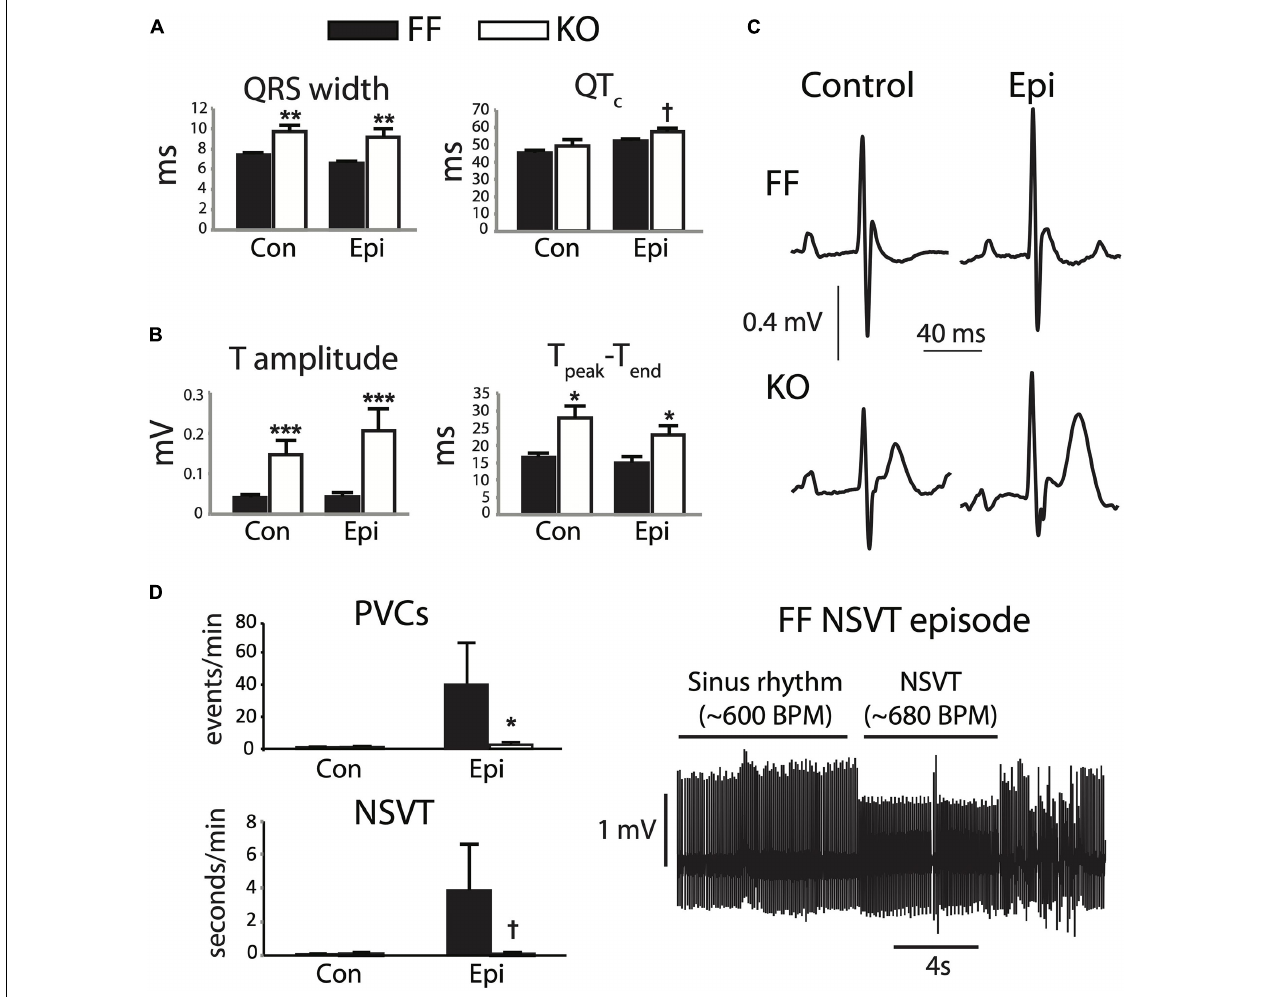
FIGURE 1 | SERCA2-KO mice exhibit unique alterations in global cardiac electrophysiology. Telemetered ECG recordings from 8 animals in each group were first analyzed for steady state characteristics from periods exhibiting only normal sinus activation sequence (A,B) . KO mice showed increased QRS width ( A , left), and marked increases in T-wave amplitude and duration (B) . (C) Typical sinus waveforms recorded from FF and KO animals. Ectopic activity was also analyzed (D) , and KO animals surprisingly exhibited a reduced frequency of total ectopy (PVC frequency, top left), and a trend for fewer runs of non-sustained VT (bottom left), during Epi challenge. All panels: † p < 0.1 KO vs. FF, * p < 0.05 KO vs. FF, ** p < 0.01 KO vs. FF, *** p < 0.001 KO vs. FF. Data are means ±